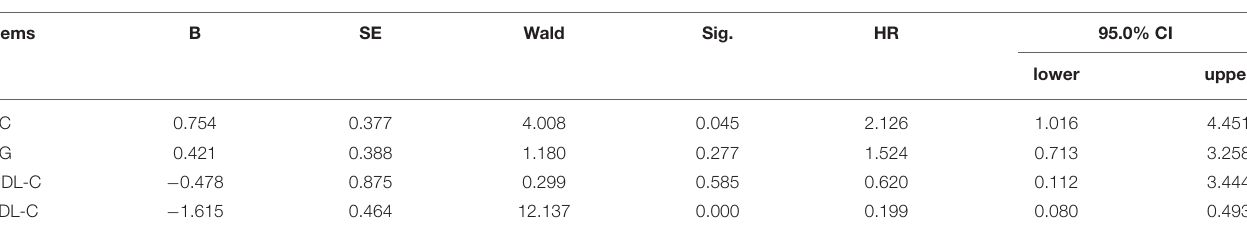
TABLE 4 | The multivariable analysis in the 90 centenarians from the recent 5 years. Items B SE Wald Sig. HR